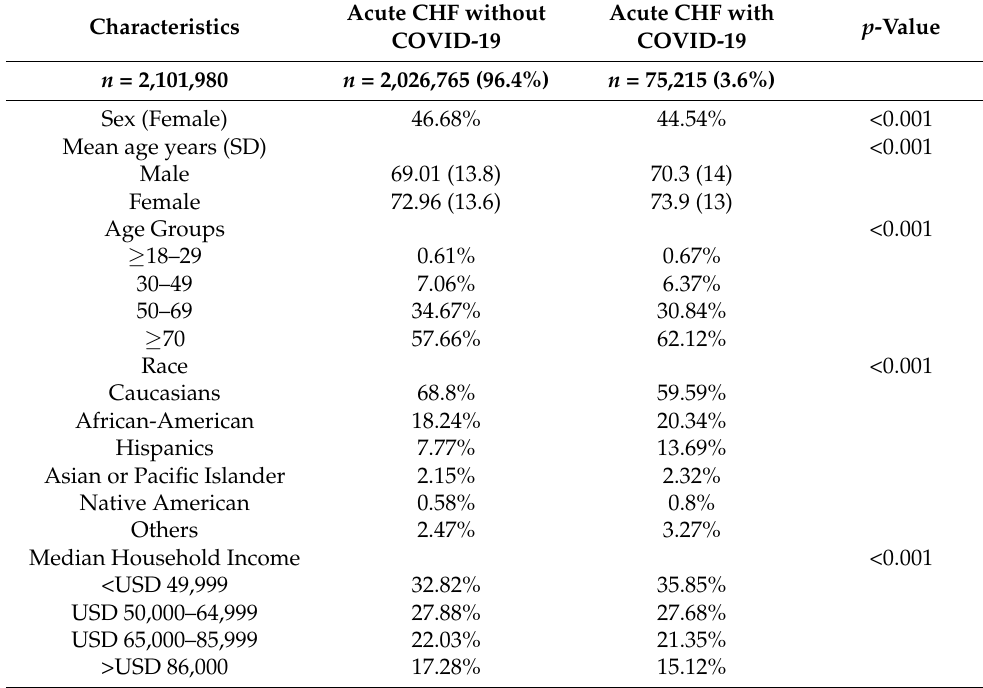
Table 1. COVID-19 and Acute Congestive Heart Failure (CHF): Unmatched Patient-level characteristics.